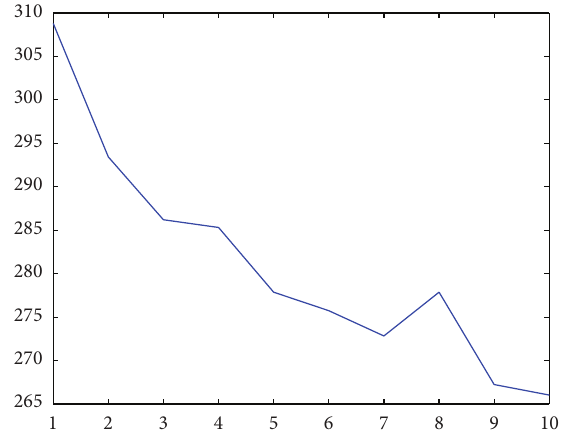
Table 2: Every class number and class centre.